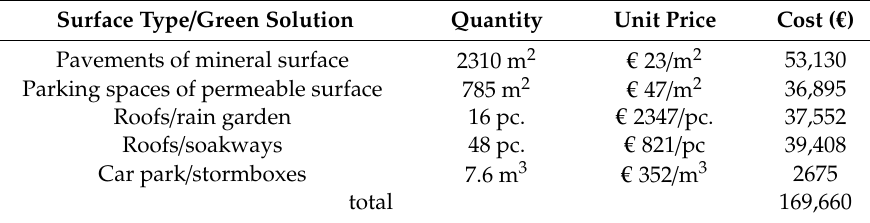
Table 14. The construction